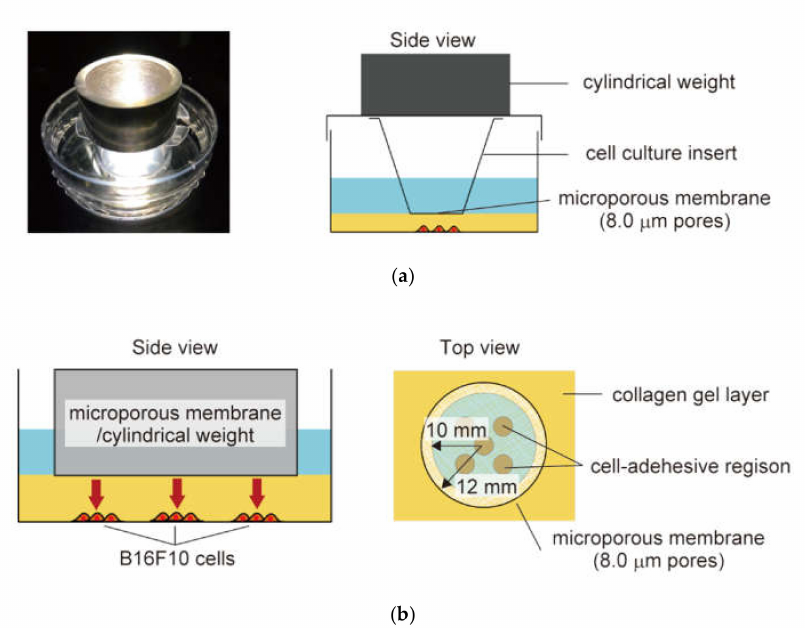
Figure 2. Schematic of the in vitro malignant melanoma model subjected to physiological compression: ( a ) The experimental set up for imposing static compression and monitoring cell proliferation and migration. A weight applies a constant compressive force to the B16F10 cells via the collagen gel layer and the microporous membrane of the cell culture insert; ( b ) The geometry of the in vitro malignant melanoma model. To assess cell proliferation and migration under constant compressive force, five cell-adhesive regions are located under the membrane of the cell culture insert. The behavior of B16F10 cells was monitored using phase-contrast and fluorescent